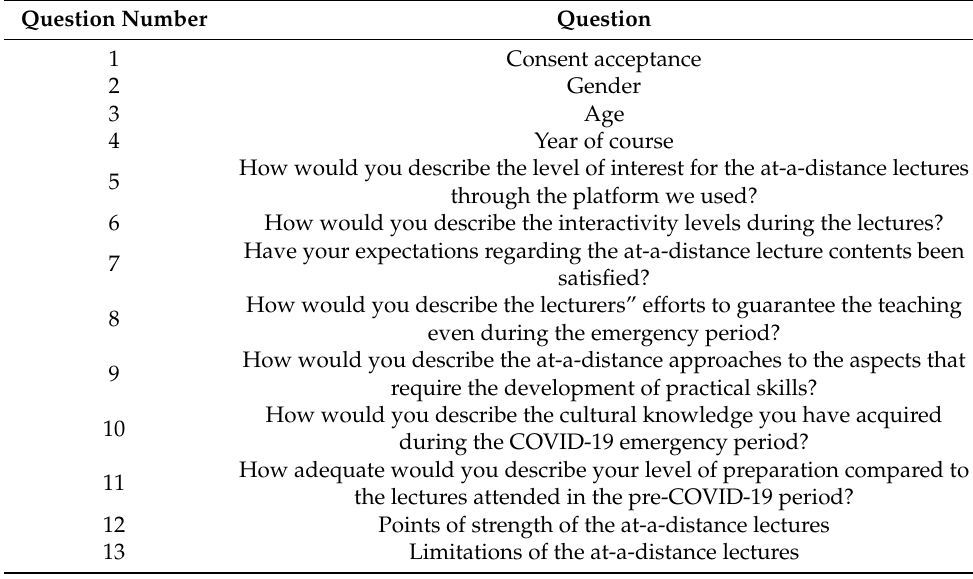
Table 1. Survey used for this study, translated into English for present